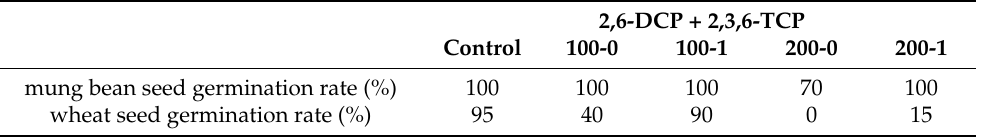
Table 6. Effects of different concentrations of mixed chlorophenol (2,6-DCP + 2,3,6-TCP) on the germination rates of mung bean and wheat seeds before and after degradation by LAC-4